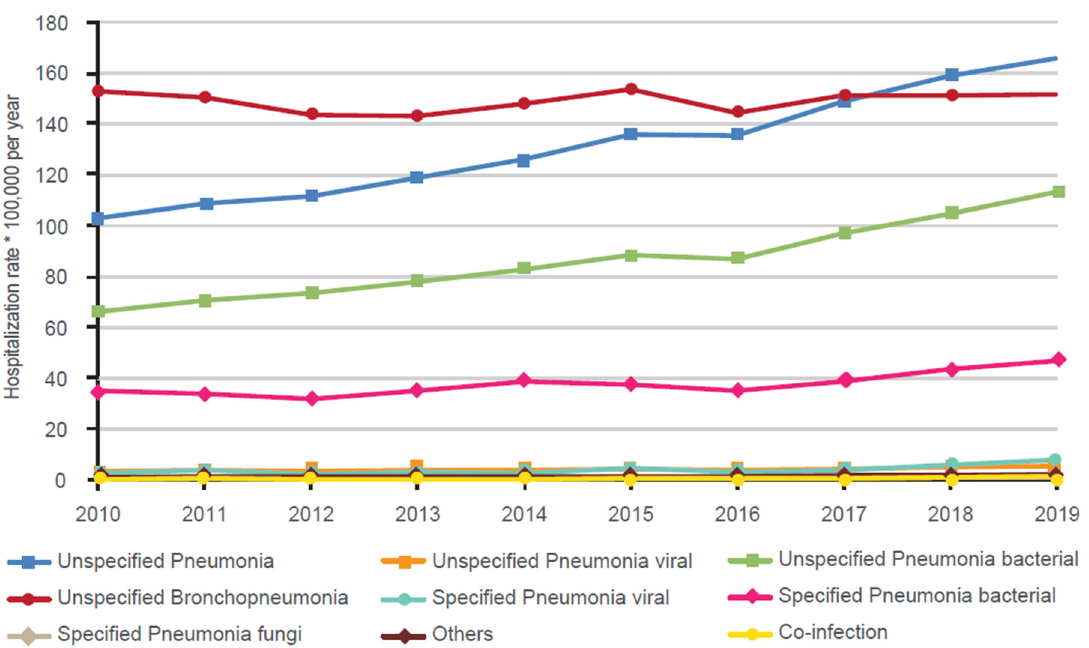
Figure 1. Trends in hospitalization rates over time according to clinical diagnosis in Italy (2010–